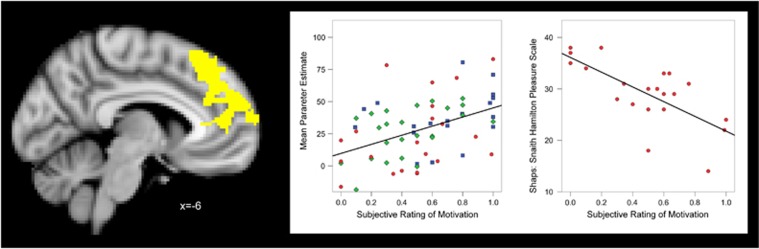
Left panel: yellow color indicates a significant cluster resulting from the linear regression of brain activation during an unexpected win against subjective ratings of task-related motivation (all participants pooled, adjusted by group). Left hemisphere is shown in the right side of the image. Coordinates are expressed in mm, and in standard space. FWE whole-brain corrected, cluster threshold Z>2.0 p<0.05. Centre panel: scatterplot of the extracted contrast parameter estimates during an unexpected win from the cluster depicted in left panel vs subjective task-related motivation (blue square, controls; green triangle, depression; red circle, schizophrenia). Right panel: scatterplot of SHAPS (Snaith Hamilton pleasure scale) score vs the subjective rating of motivation in the schizophrenia group.